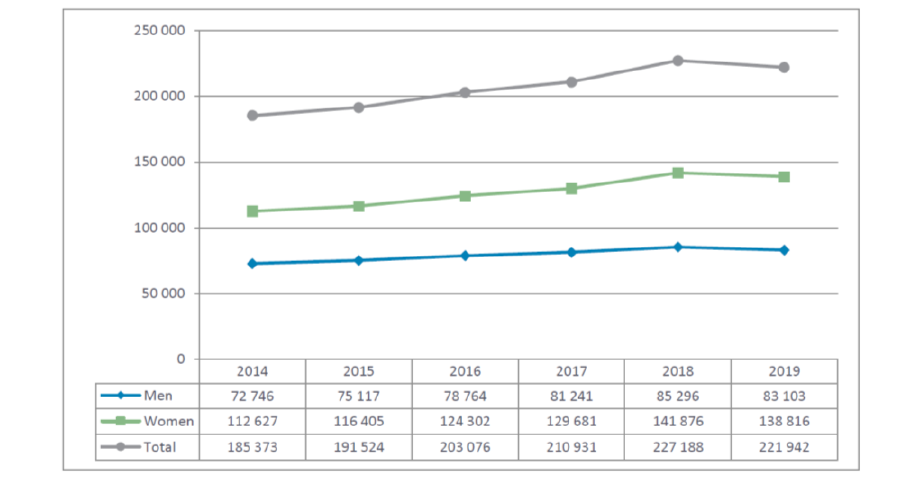
Figure 1 : Headcount graduates by gender from 2014 to